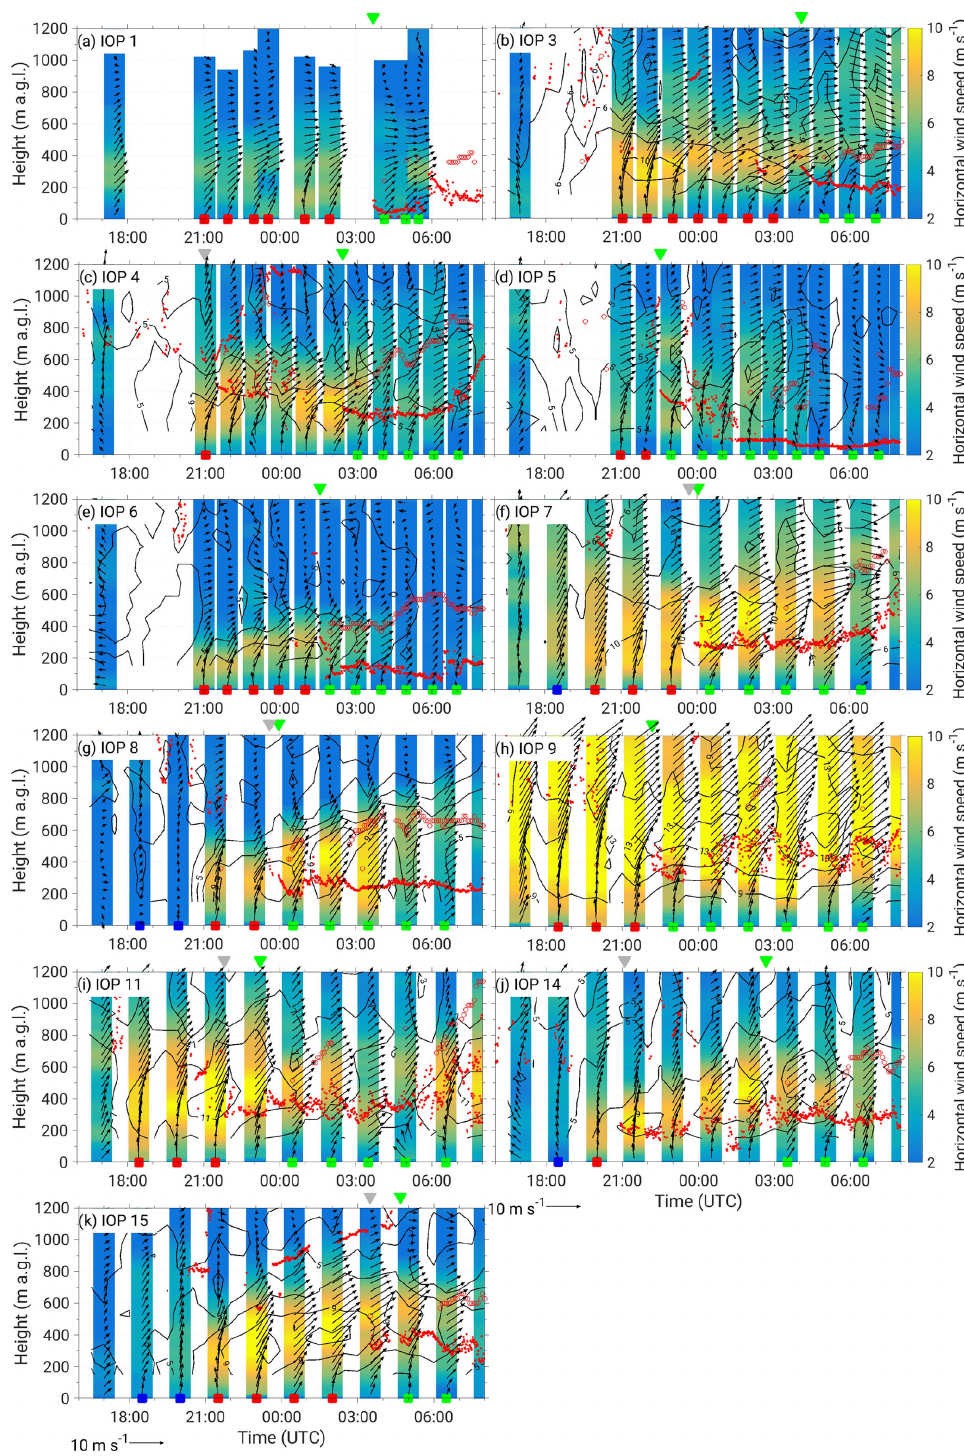
Figure 3. Horizontal wind speed from radiosondes (color coded) and from the UHF profiler (contour, 2ms − 1 increments) and horizontal wind vector from radiosondes (arrows) for IOPs analyzed in this study. The vertical bars are centered on the launch times of the radiosondes. Red dots indicate cloud base from ceilometer measurements and red circles cloud top from cloud-radar measurements. At the top of each plot the onset time of stratus is indicated by the green triangle. The gray triangle marks the onset time of stratus fractus if it occurred during the respective night. Blue, red and green squares at the bottom of each plot indicate radiosoundings considered in the averaged profiles for the stable, jet and stratus